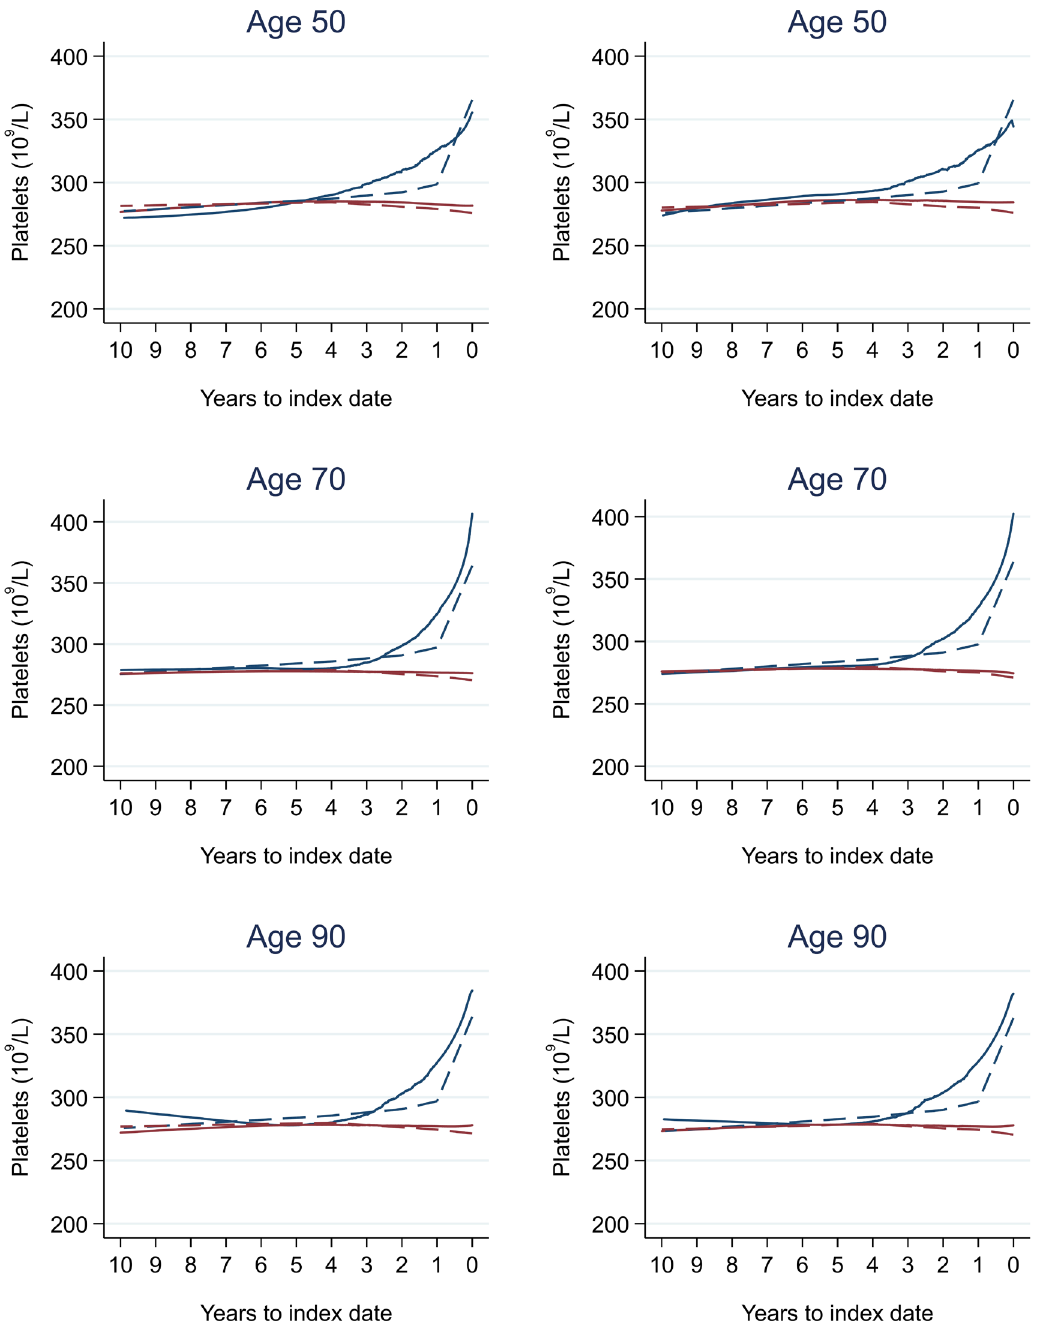
Figure 24. Platelets trends for females by age at index 1,2 : unmatched (left) and matched (right). 1 Index date was the date of diagnosis for cases and a randomly selected date in the patient’s study period for controls. 2 LOWESS trends are age (+/- 3 years) and modelled (fixed effects) trends are taken at that specific age. Legend: colorectal cancer (blue line) and no cancer (red line). LOWESS trend (solid line) and modelled trend (dashed line).